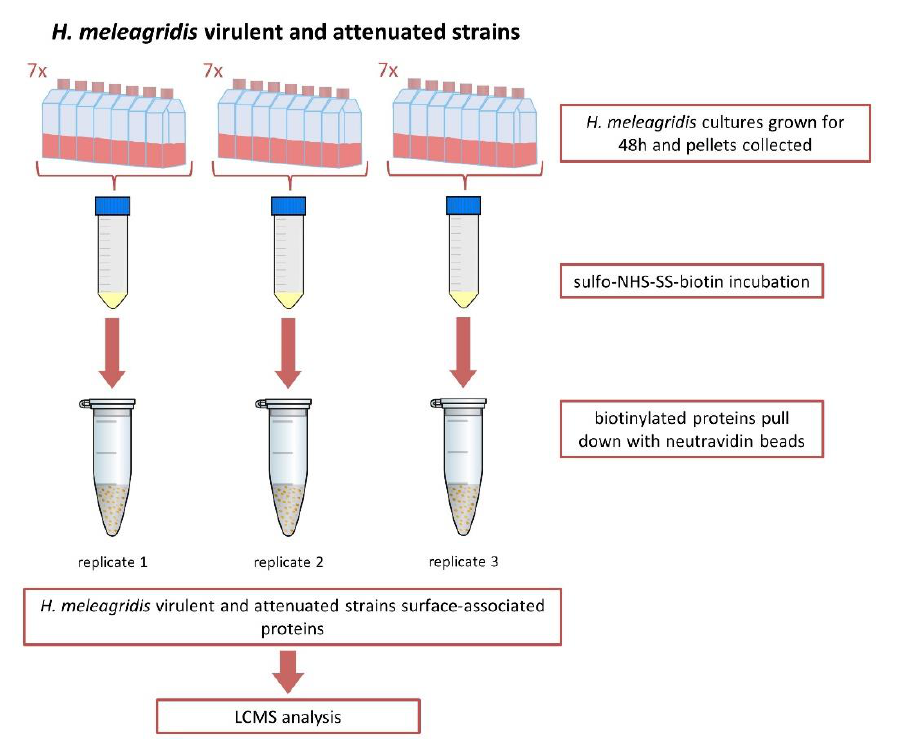
Figure 1. Experimental set-up. Schematic representation of the experimental set-up used for biotinylation and purification of H. meleagridis surface-associated proteins. The protozoan was incubated in seven T75 flasks. After 48 h, the cultures were centrifuged, and the pellets were collected and incubated with sulfo-NHS-SS-biotin. Biotinylated proteins were pulled down with neutravidin beads, selecting for surface-associated proteins. Samples were analyzed with mass spectrometry.